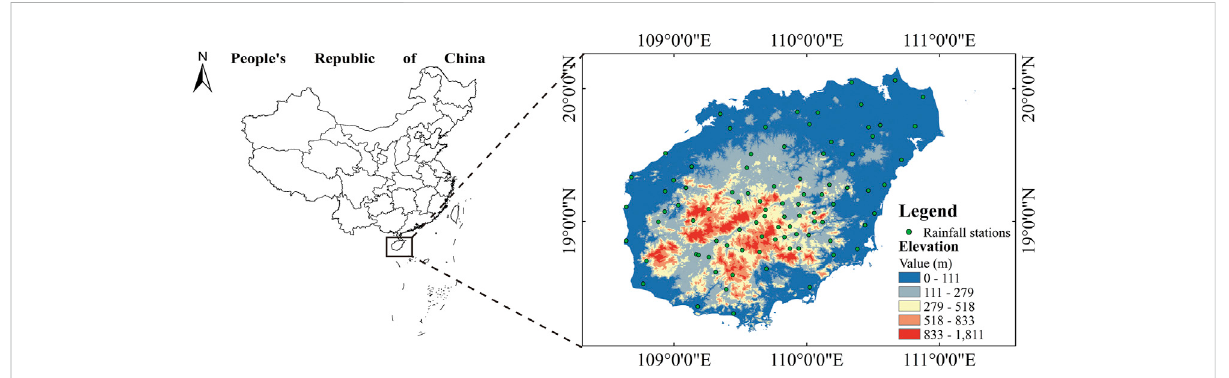
FIGURE 1 Geographical location, elevation and rainfall stations distribution of Hainan